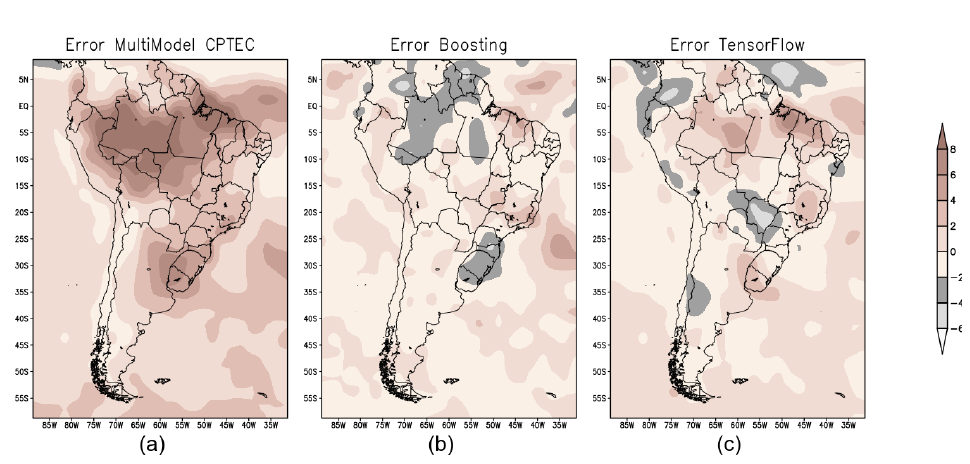
Figure 4. Error map to evaluate the performance of the forecast models: ( a ) BAM; ( b ) XGB; and ( c ) TF.